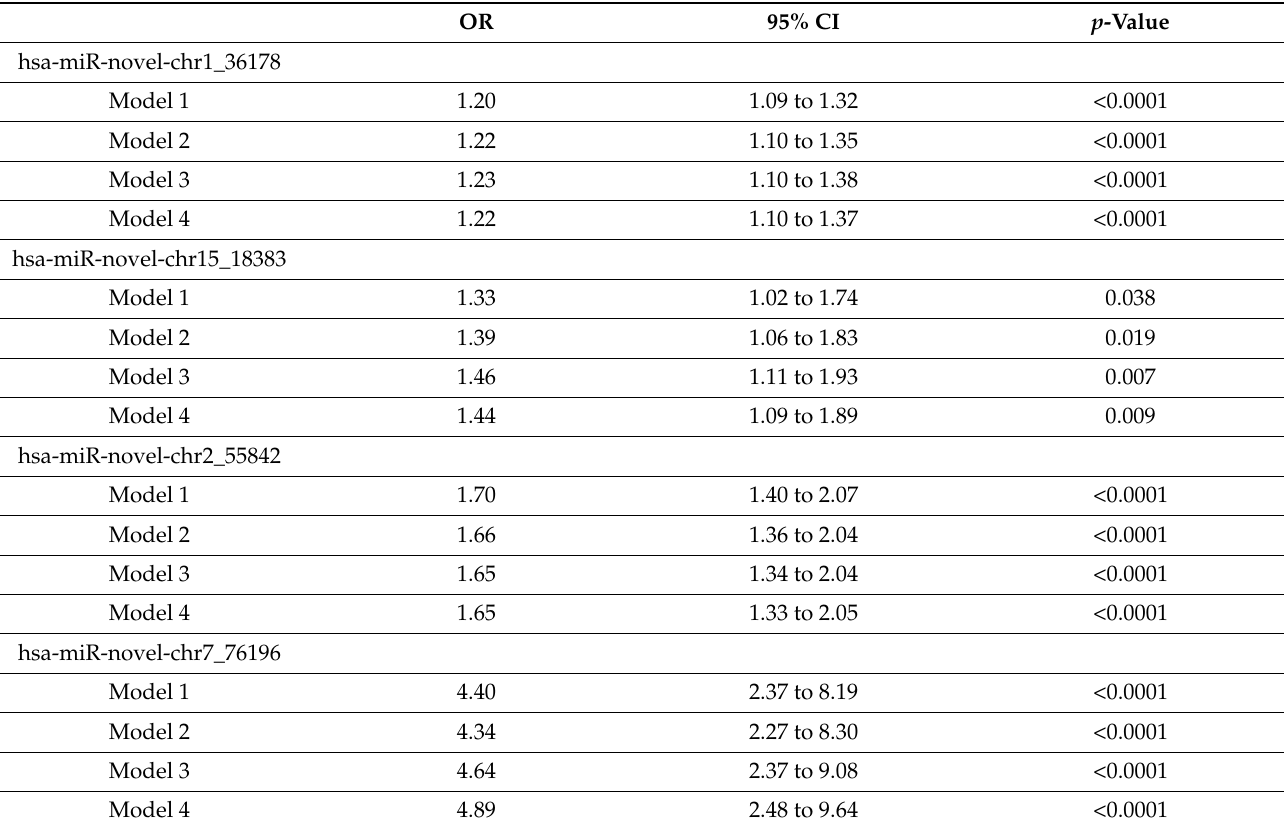
Table 3. Logistic regression analysis of blood miRNAs for prediction of